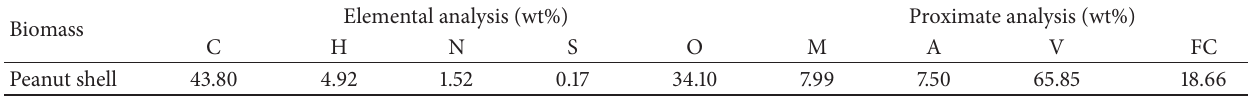
Table 1: Elemental and proximate analysis of peanut shell.